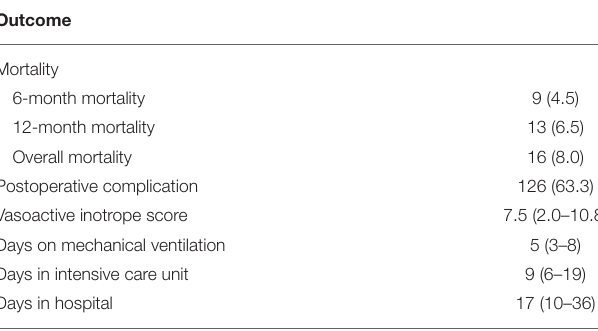
TABLE 5 | Surgical outcomes ( M = 199). Outcome